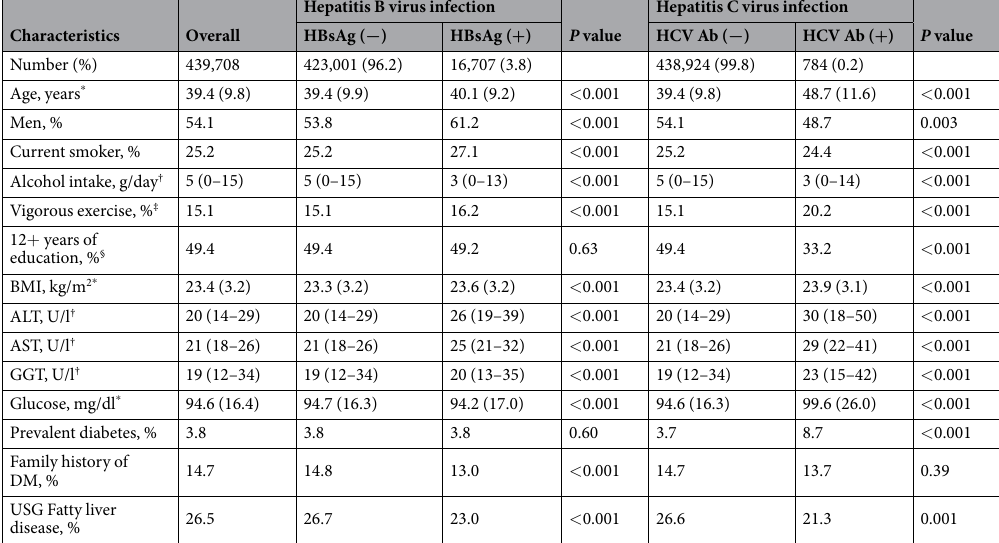
Table 1. Participant characteristics by hepatitis virus infection at baseline in cross-sectional analysis ( n = 439,708). Values are * means (standard deviation), † medians (interquartile range), or percentages. ‡ ≥ 3 times per week. Abbreviations: ALT, alanine aminotransferase; AST, aspartate aminotransferase; BMI, body mass index; DM, diabetes mellitus; GGT, gamma-glutamyl transferase; USG,